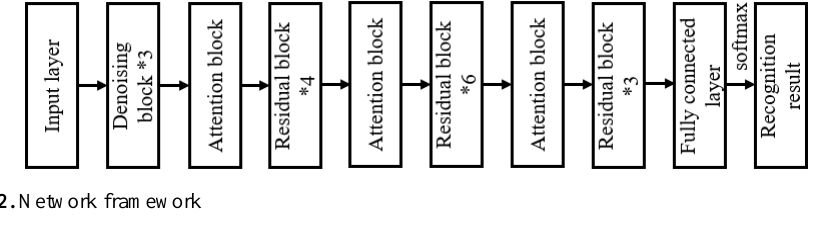
Fig. 2. Network framework